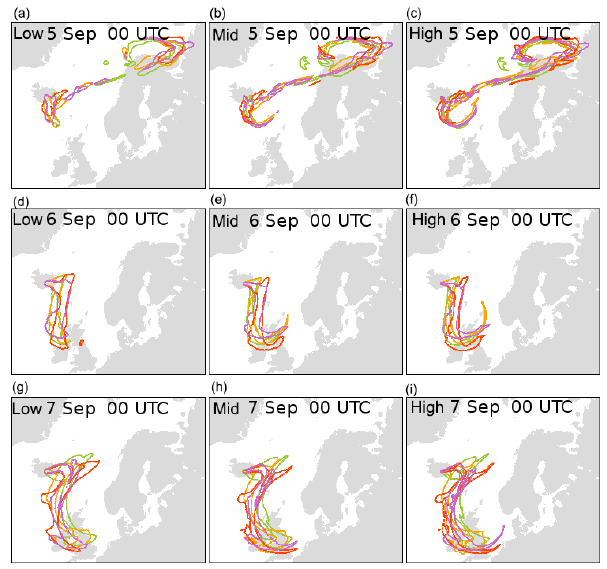
Figure 4. The 5DU contour lines for four exemplary members af- ter 48h of forecast in the low, mid, and high resolution ensembles, in the left, middle, and right columns respectively, for start time 00:00UTC on 3 September (a, b, c) , 00:00UTC on 4 September (d, e, f) , and 00:00UTC on 5 September (g, h, i)